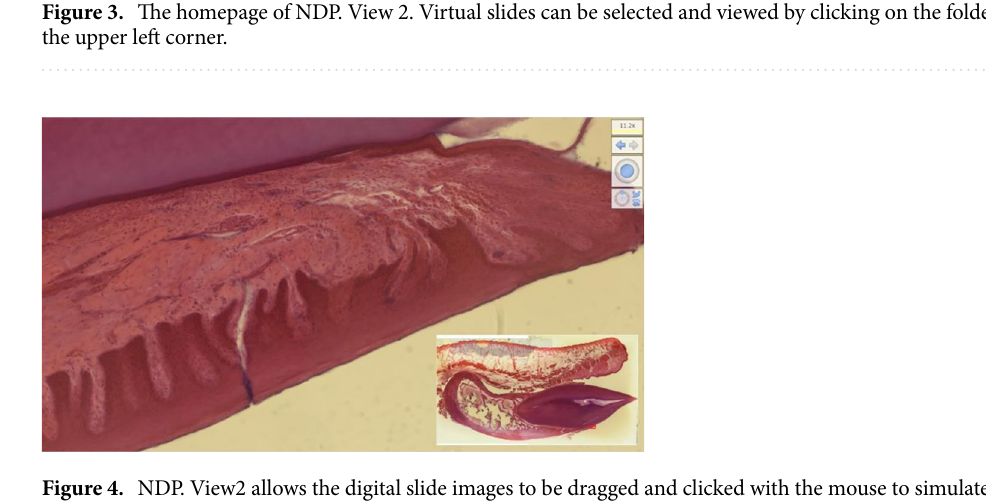
Figure 4. NDP. View2 allows the digital slide images to be dragged and clicked with the mouse to simulate the scanning of the corresponding glass slides under a light